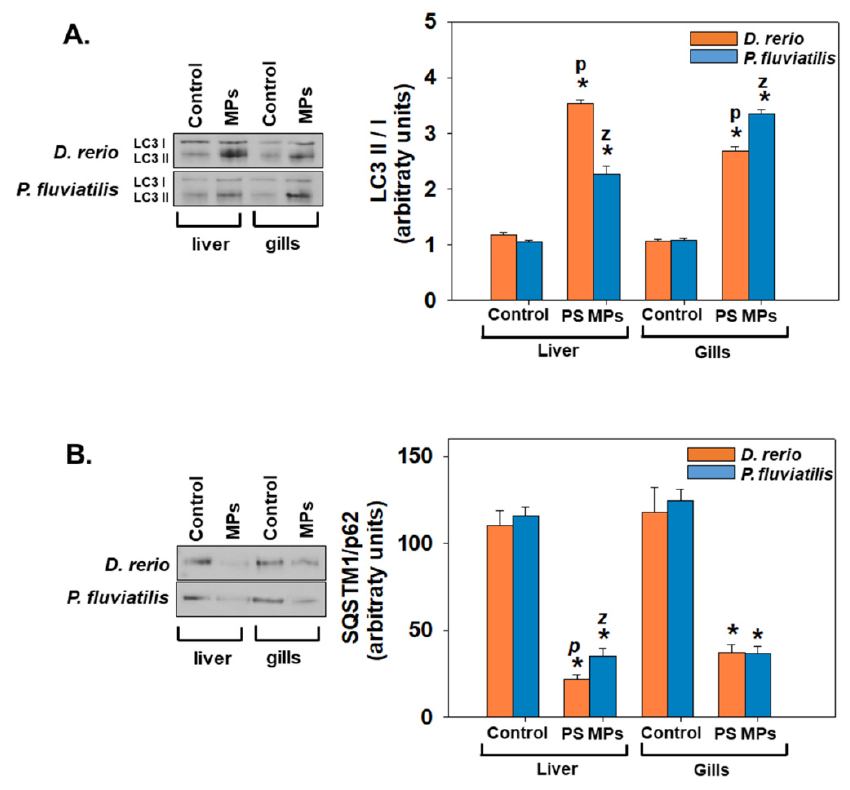
Figure 8. LC3II/I ratio ( A ) and SQSTM1/p62 levels ( B ) (mean ± SD) in liver and gills of Danio rerio ( n = 3 pools of 10 individuals) and Perca fluviatilis ( n = 6). Tissue extracts from all groups were immunoblotted for LC3II/I and SQSTM1/p62. Blots and dots were quantified using scanning densitometry. Representative blots and dots are shown. Mann–Whitney U test was employed to test for significance at p < 0.05 between all experimental groups. * denotes significant differences ( p < 0.05) compared to the control group ( n = 3 pools of 10 individuals and n = 6 for D. rerio and P. fluviatilis respectively), while z and p denote significant differences ( p < 0.05) between D. rerio and P. fluviatilis respectively.